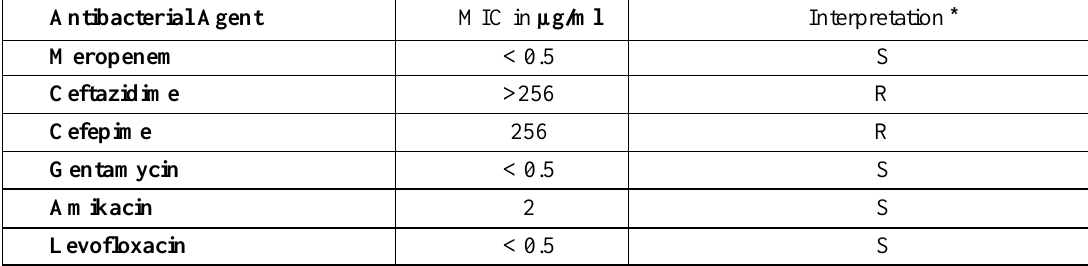
Table 2. Susceptibility pattern of our isolate.